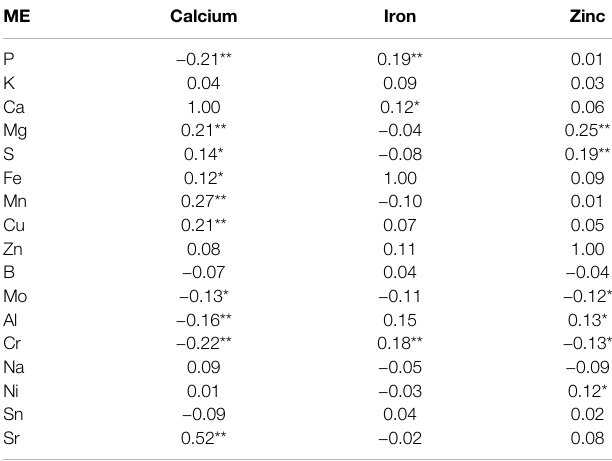
TABLE3| Thecorrelation(partial)resultofcalcium,ironandzincwithall17mineral elements content of brown rice of Towada